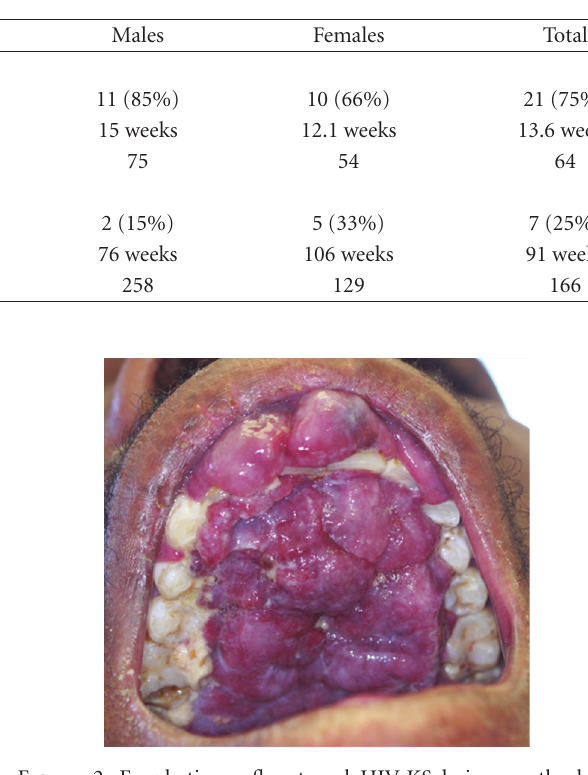
Table 4: Mortality and survival in relation to oral HIV-KS.